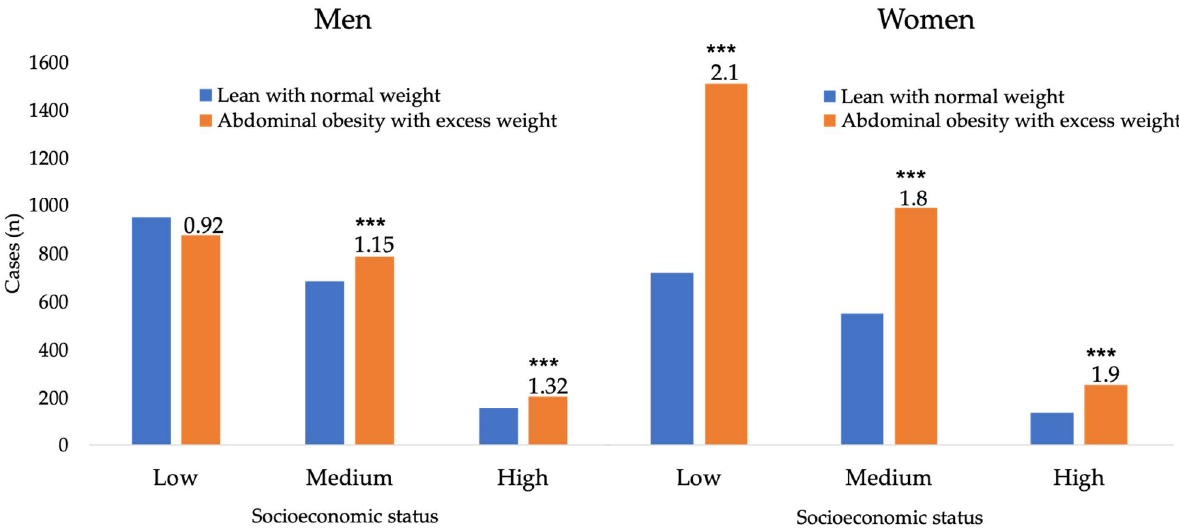
Figure 1. Proportion of men ( left ) and women ( right ) with or without abdominal obesity and excess weight among the socioeconomic statuses. *** p < 0.0001: lean body and normal weight vs. abdominal obesity and excess weight. Significant differences correspond to chi-squared analysis within each category of socioeconomic status (see main text for details).